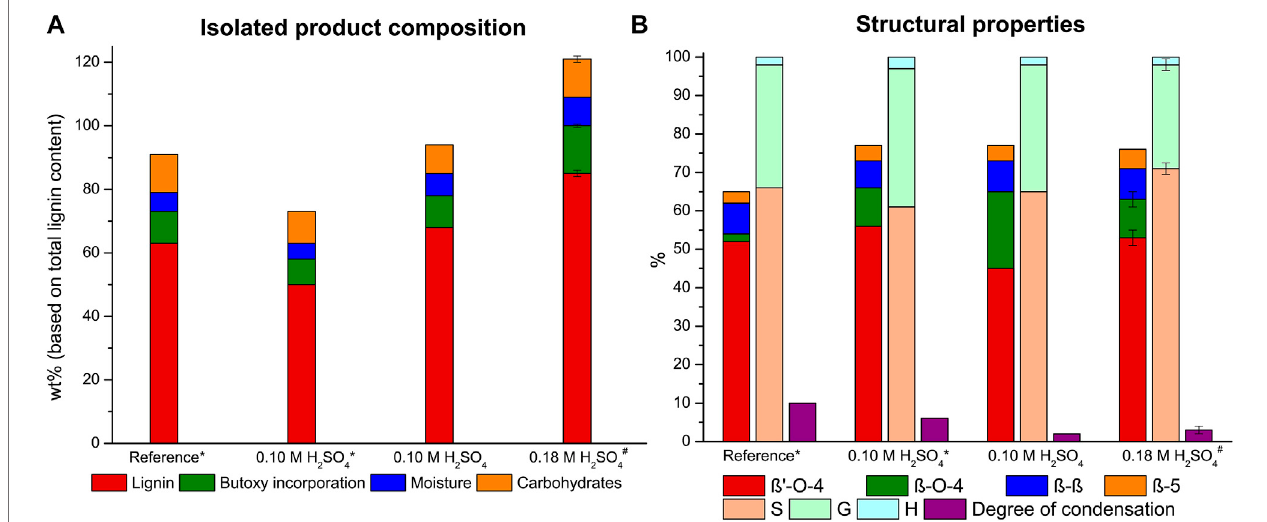
FIGURE 2 | Lignin extraction ef fi ciency with product composition with each component expressed as a percentage of the total lignin content (A) and the linkage content (per 100 C9 units), S/G/H ratio and the degree of condensation (based on condensed S-units) (B) of the isolated butanosolv lignin for the reference extraction (80:15:5 nBuOH/H 2 O/1,4-dioxane, 0.18 M H 2 SO 4 ) and the optimization study with a 9:1 nBuOH/H 2 O ratio. * half reactor loading # average of two